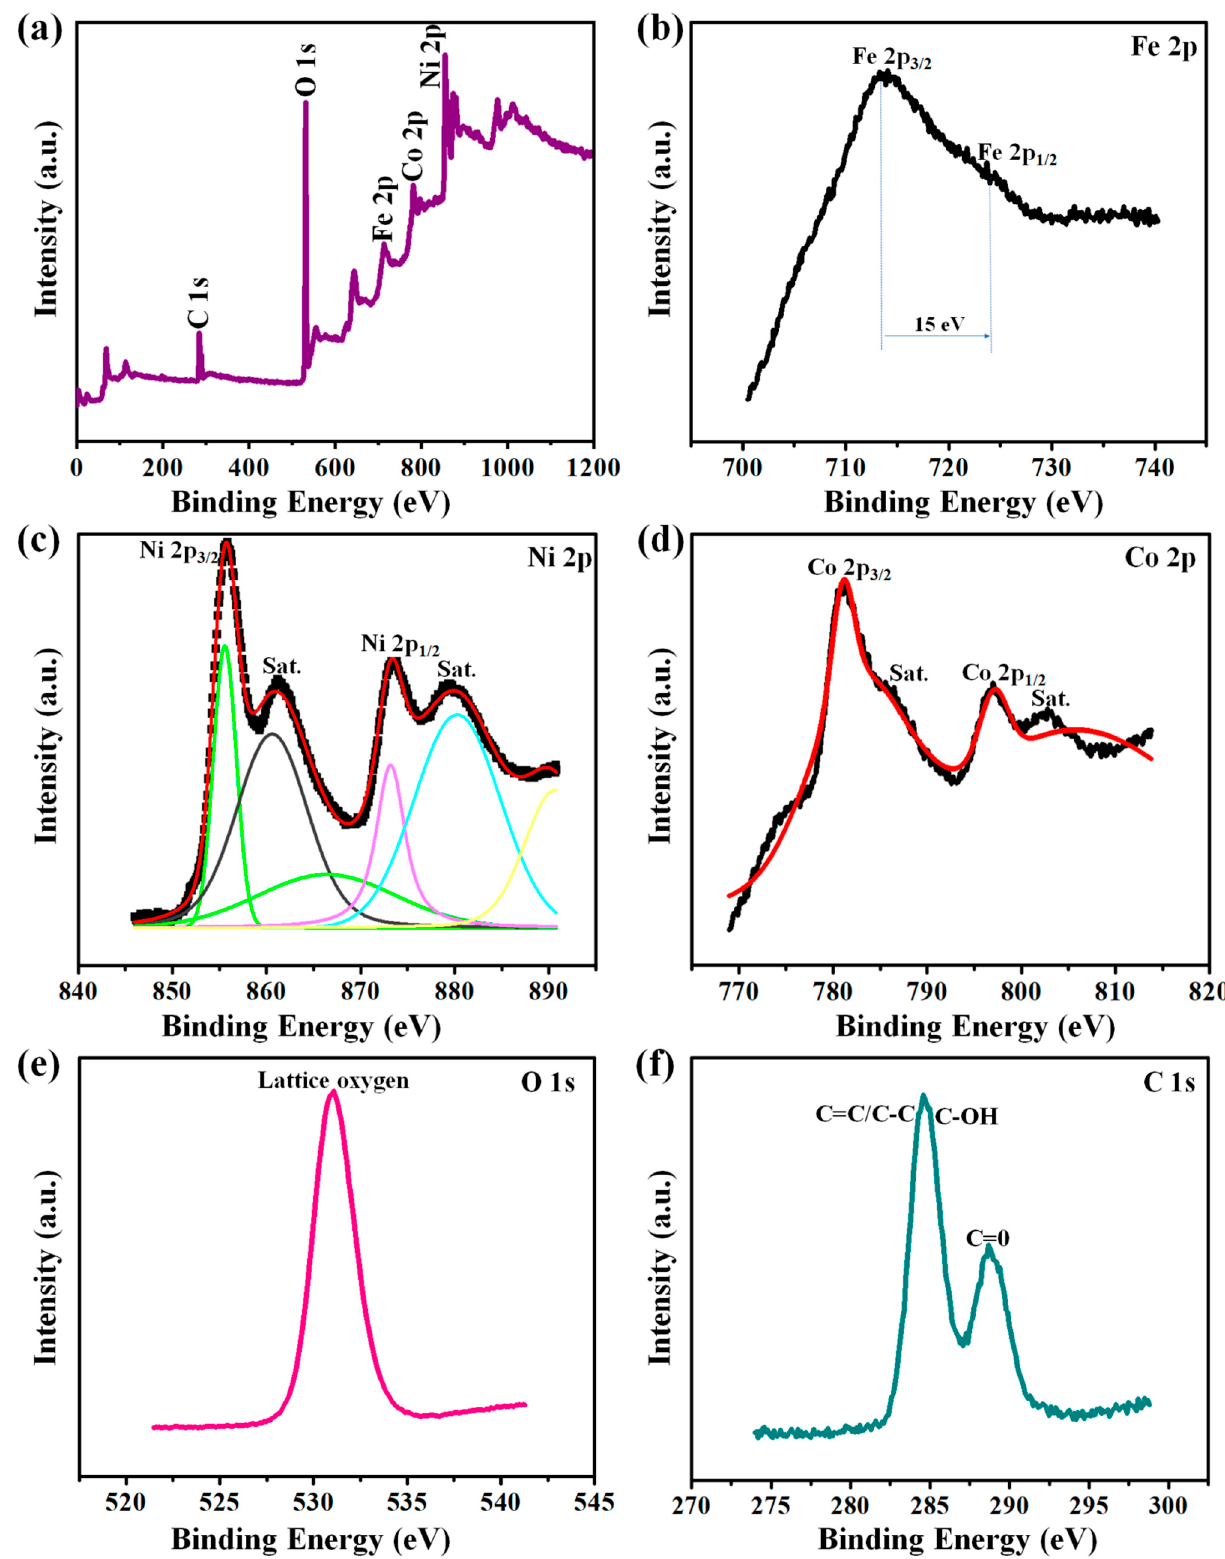
Figure 5. XPS spectrum of Fe-dopant@NiCoO x @NF nanoneedle composite: ( a ) XPS survey spectrum, ( b – e ) high-resolution spectrum of ( b ) Fe 2p, ( c ) Ni 2p, ( d ) Co 2p, ( e ) O 1s, and ( f ) C1s.